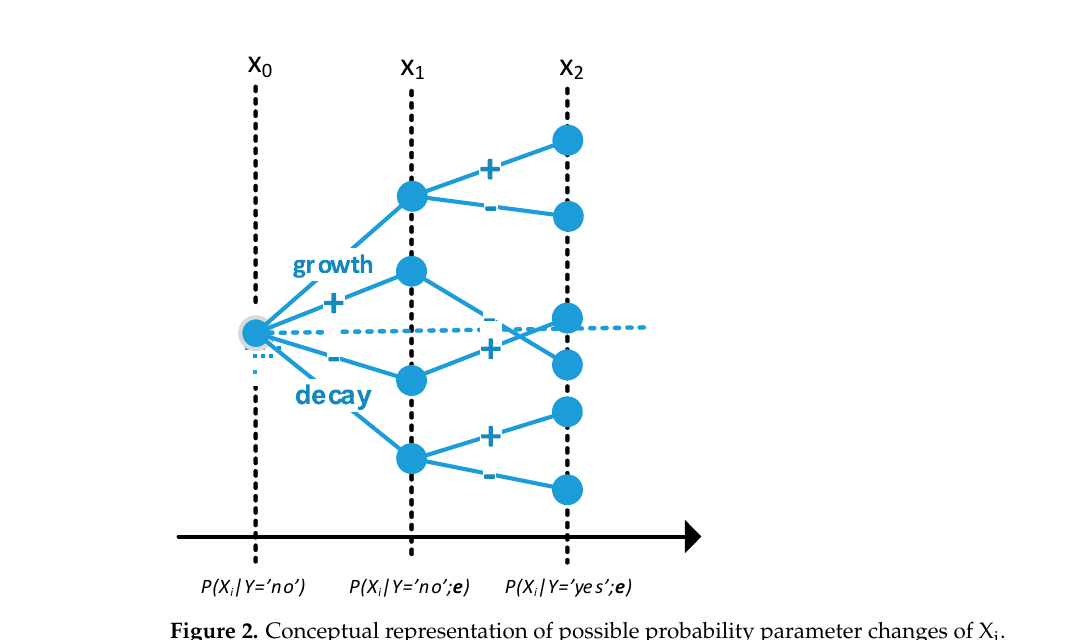
Figure 2. Conceptual representation of possible probability parameter changes of X i .